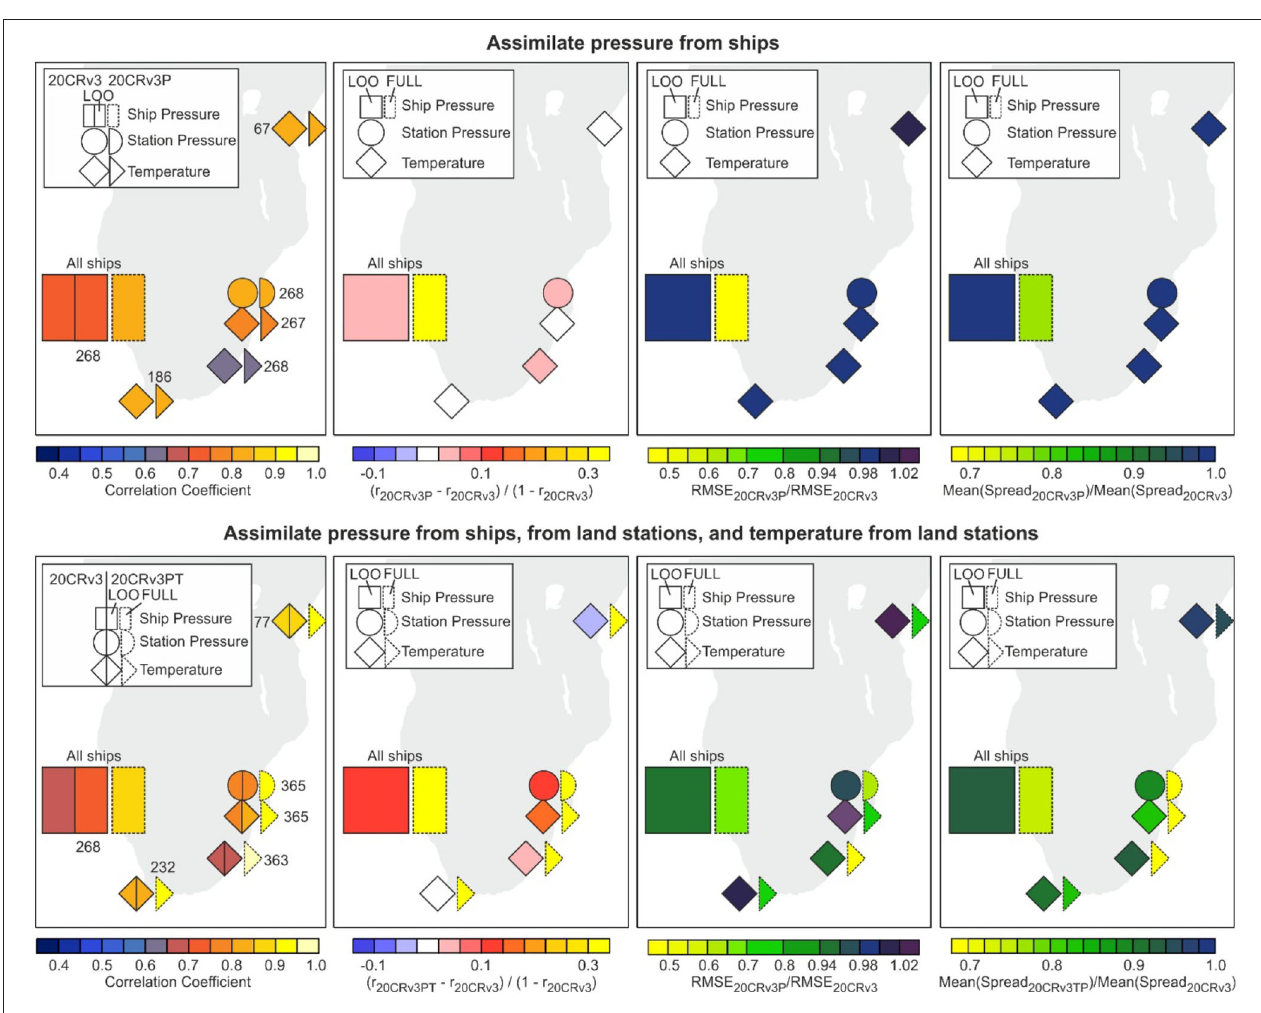
FIGURE 5 | Results for 1877/78 for correlation, scaled improvement, ratio of RMSE, and ratio of ensemble spread. Top: Assimilating only ship pressure, bottom: assimilating ship pressure as well as land station data. The numbers in the left panels indicate the observation pairs used for each correlation. Dashed outlines indicate results from the FULL assimilation that are not independent, solid outlines are based on independent data (data retained for evaluation or LOO approach). Note that the color-scale for the RMSE ratio is not